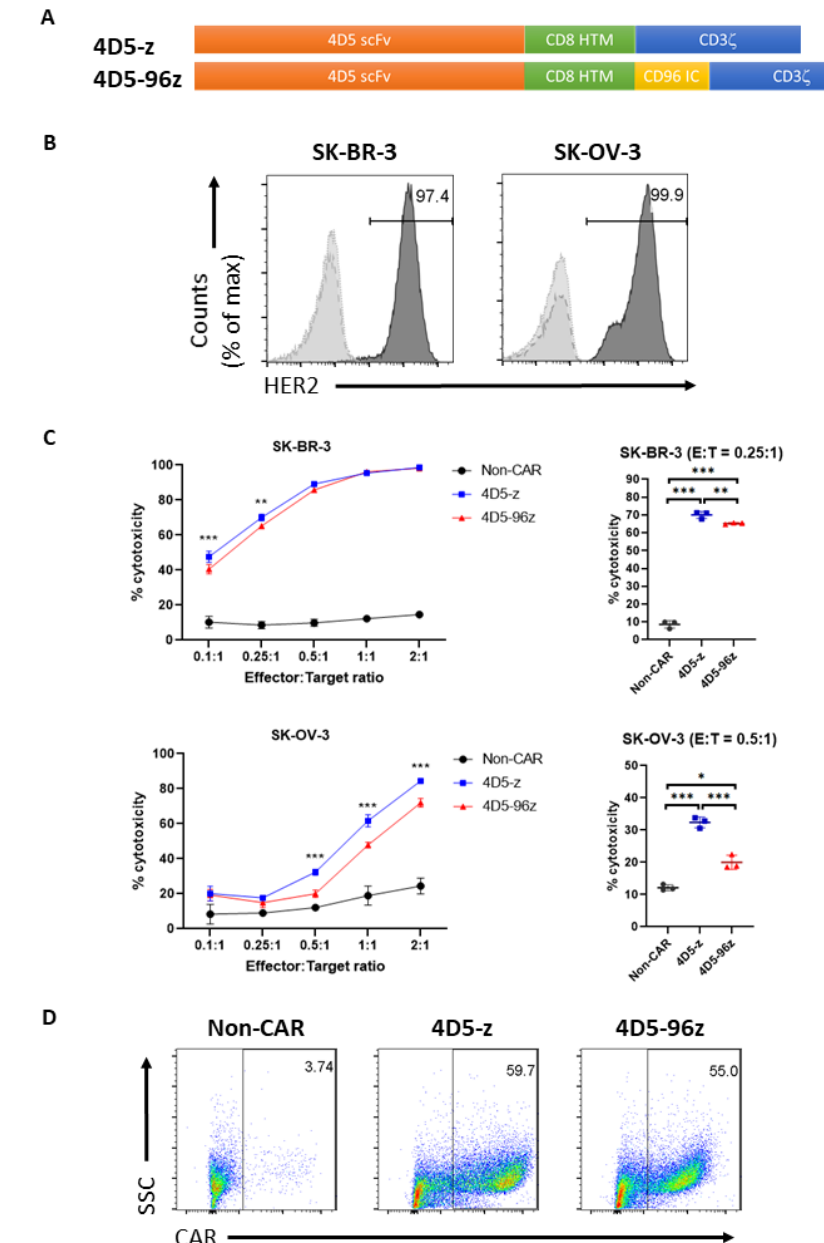
Figure 3. Inclusion of CD96 endodomain in 4D5-z CAR-T cells cripples their cytotoxicity against HER2 + tumor cells in vitro. ( A ) Schematic diagram of 4D5-z and 4D5-96z CAR constructs. scFv, single chain variable fragment; HTM, hinge and transmembrane domain; IC, intracellular signaling domain. ( B ) Expression of HER2 on SK-BR-3 and SK-OV-3 cells as assessed by flow cytometry. Dashed and dotted histograms represent unstained and isotype control cells, respectively. ( C ) Percentage (%) cytotoxicity of CAR-T cells against luciferase-expressing SK-BR-3 and SK-OV-3 cells 20 h after co-culture with T cells at indicated E:T ratios (left panels). For clarity, only statistical significance resulting from comparisons of % cytotoxicity of 4D5-z and 4D5-96z CAR-T cells are shown. Dot plots (right panels) show % cytotoxicity of non-CAR and CAR-T cells against SK-BR-3 and SK-OV-3 cells at E:T of 0.25:1 and 0.5:1, respectively. ( D ) Efficiency of CAR transduction as assessed by flow cytometry. Quadrant gates were applied based on CAR staining for non-CAR-T cells. Data in (C) are the mean ± SD of 3 technical replicates; two-way ANOVA with Tukey post hoc analysis, *, p < 0.05; **, p < 0.005; ***, p < 0.001. Data in ( C , D ) are representative of 2 independent experiments using 3 different